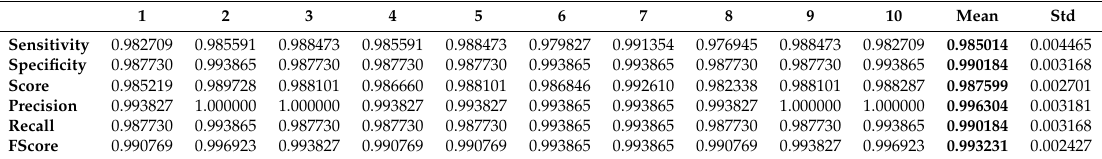
Table 3. All the iteration results for the 10 cross validation step using the proposal combination of Variational AutoEncoder (VAE) for data augmentation and a CNN for the classification step on chronic diseases